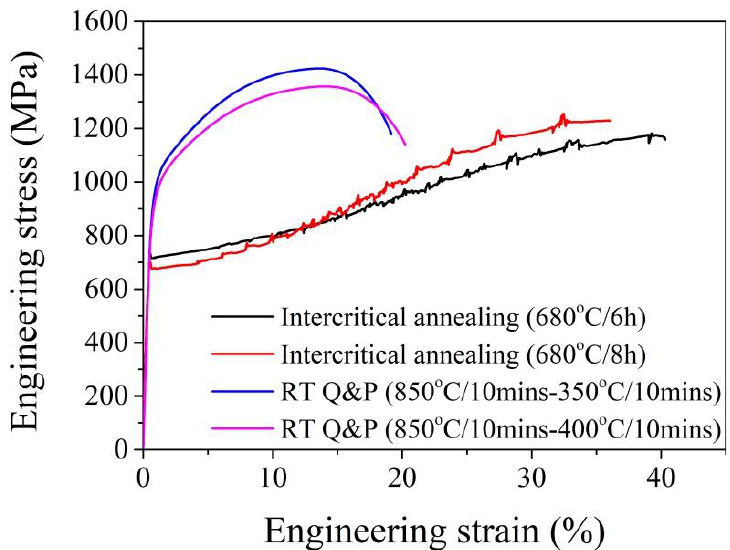
Figure 9. Engineering stress – strain curves of a medium Mn steel (Fe-10Mn-0.2C-2Al-0.1V in wt.%) treated by different thermal processes including intercritical annealing and room temperature quenching and partitioning (RT Q&P).